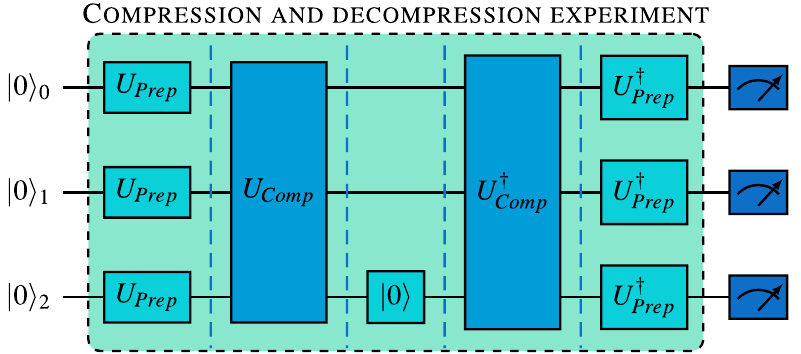
0 are | � 0 , 1 , , , , ψ y y from the set using the {| � | � |+� |−� | | | � + � − �} ψ are compressed using the compression algorithm | � 0 . This marks the end of the compression part, after which the | � 000 state and the probability | �